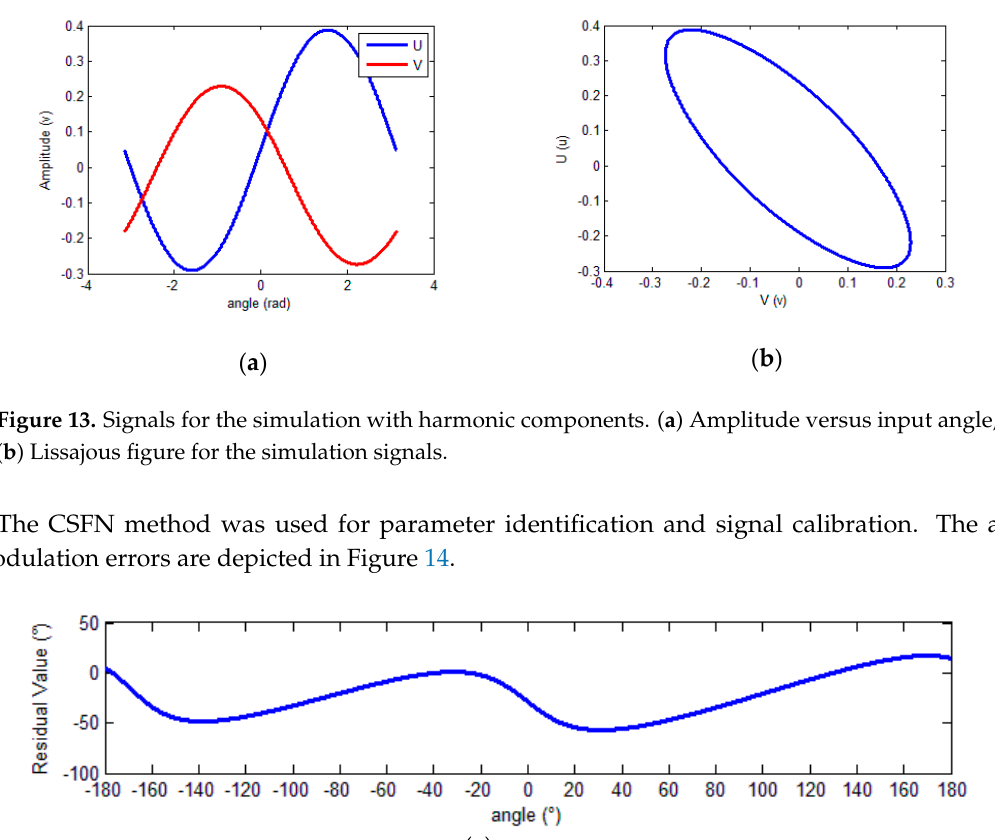
Figure 12. Demodulation errors. ( a ) Demodulation error before calibration; ( b ) demodulation error after calibration.